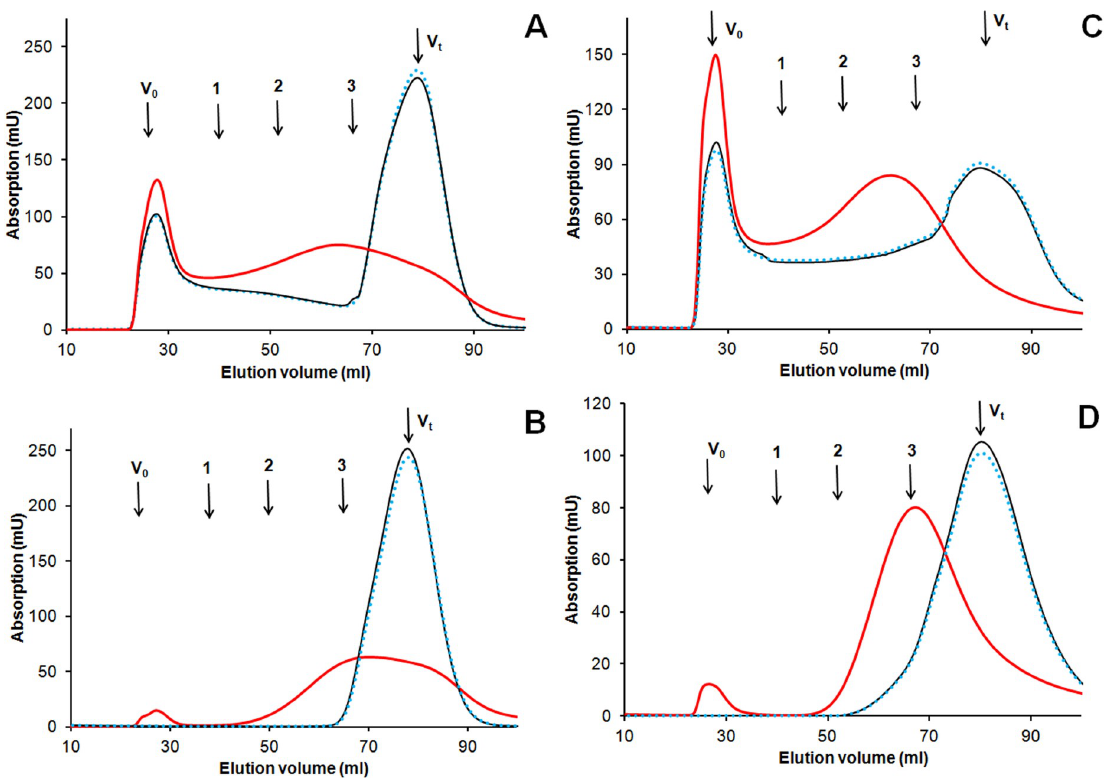
Fig 4. Gel-filtration profiles for transformation of ferulic acid, caffeic acid and their mixtures with HA by SpSL. (A) ferulic acid and humic acid; (B) ferulic acid; (C) caffeic acid and humic acid; (D) caffeic acid. Solid red line–sample after interaction with SpSL, thin black line–initial sample, dotted blue line–control with inactivated SpSL. Arrows indicate the void volume (V 0, > 80 kDa), the total void volume (V t , < 5 kDa), 1—bovine serum albumin (66 kDa), 2—carbonic anhydrase (29 kDa), cytochrome c 12.4 kDa).